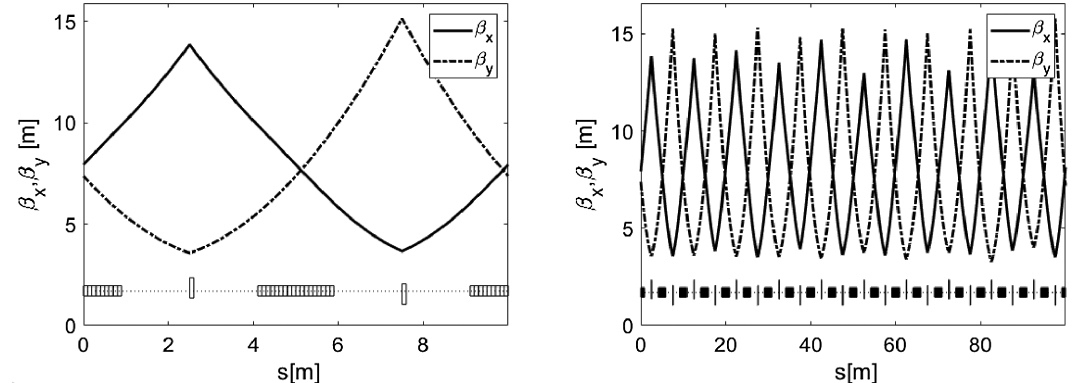
FIG. 1. Left: the beta functions of one cell. Right: the beta functions of the ring where the focal lengths of all quadrupoles are randomly perturbed by 5% which causes a moderate